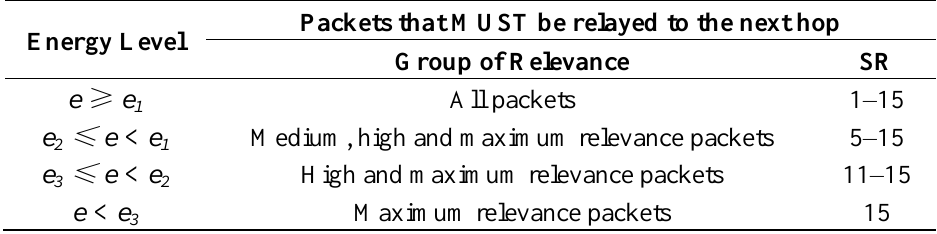
Table 3. Energy thresholds for the SR-based relaying